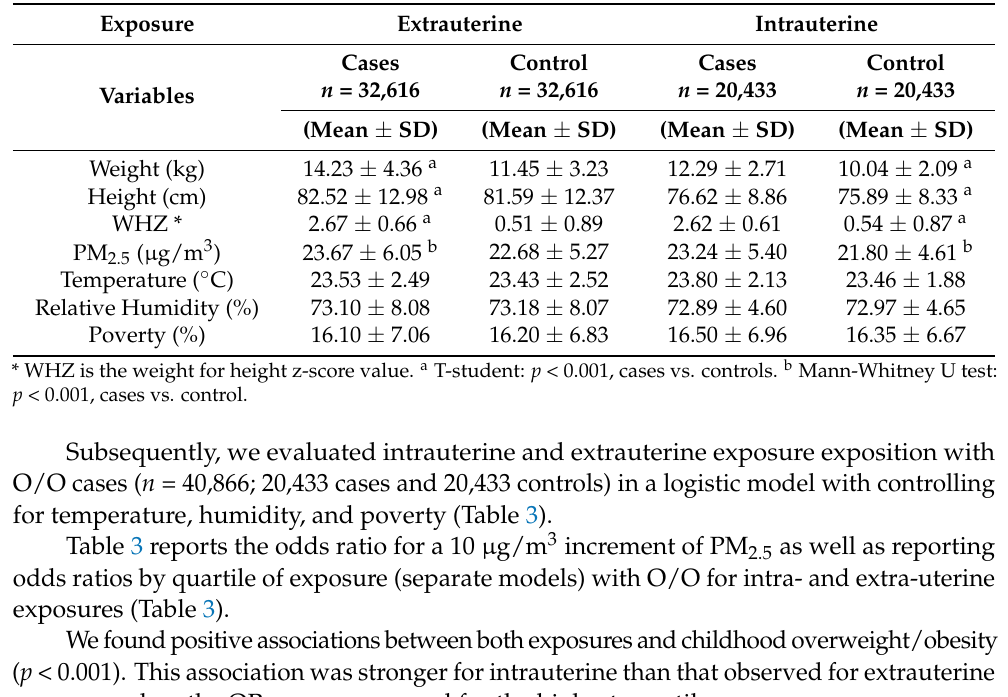
Table 2. Population